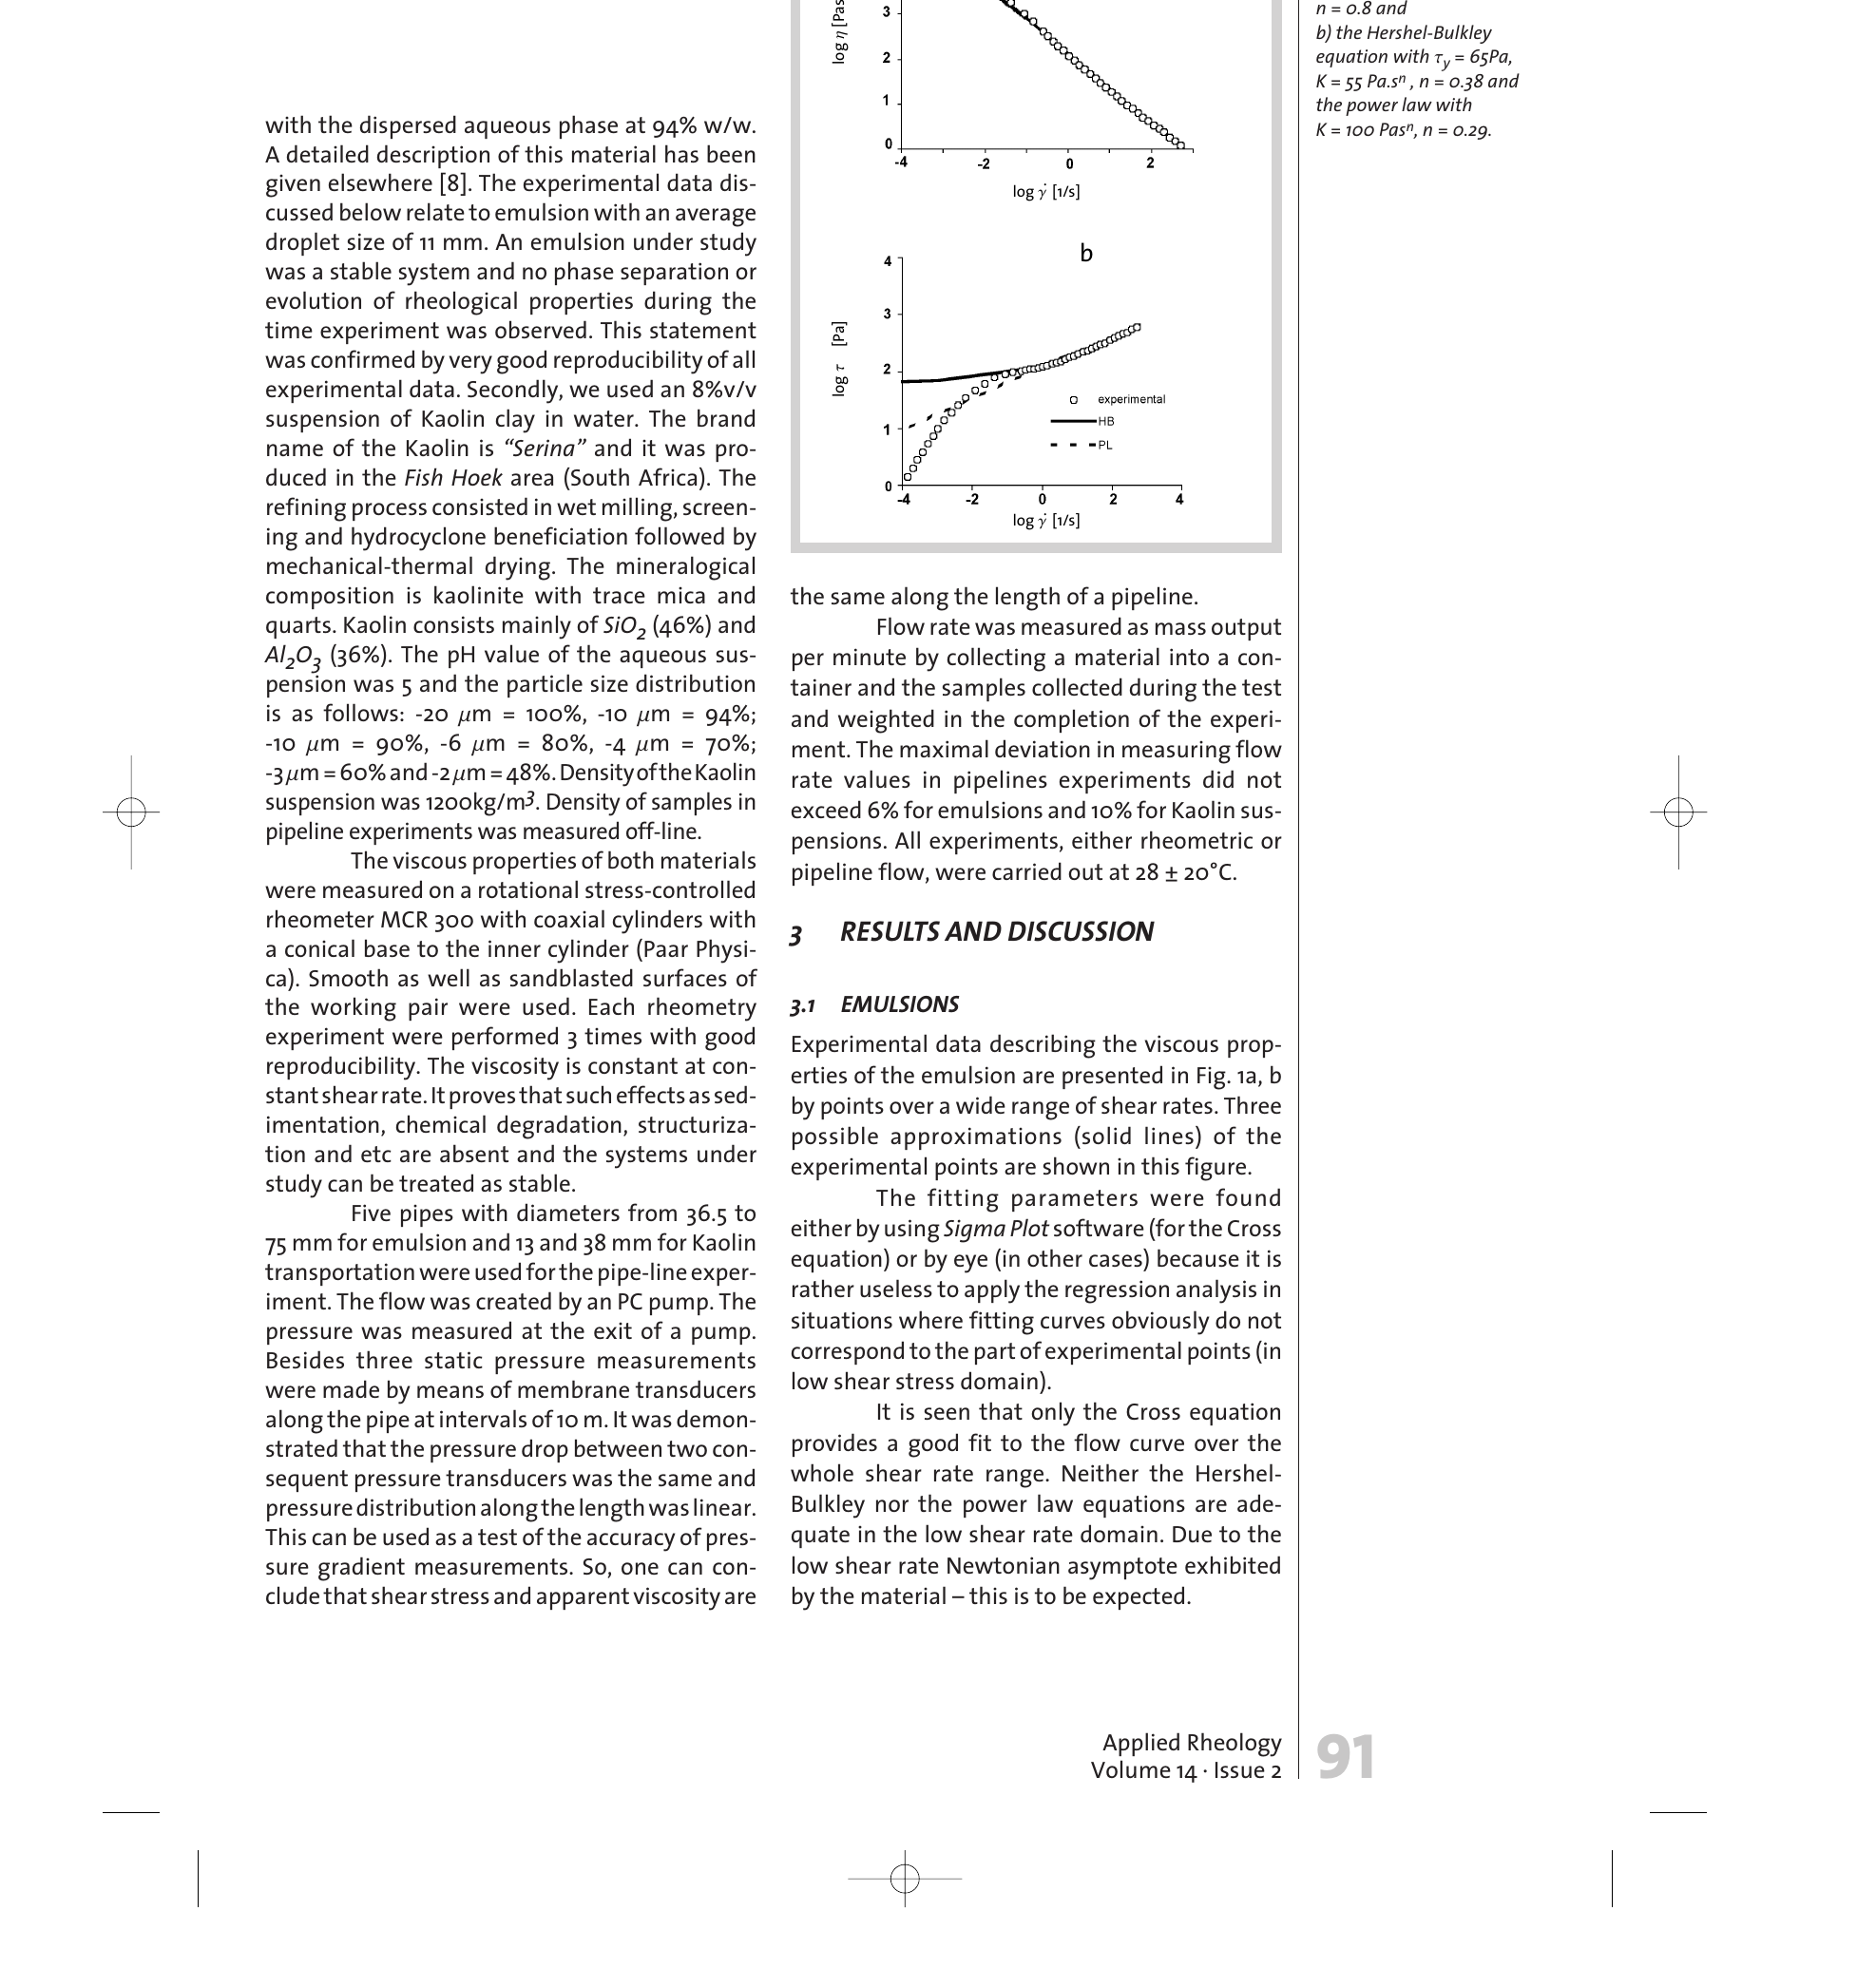
Figure 1: Approximations of the experimental data for the emulsion by the Cross equation with a) h 0 = 1.12*10 4 Pas, l = 245s, n = 0.8 and b) the Hershel-Bulkley equation with t y = 65Pa, K = 55 Pa.s n , n = 0.38 and the power law with K = 100 Pas n , n =